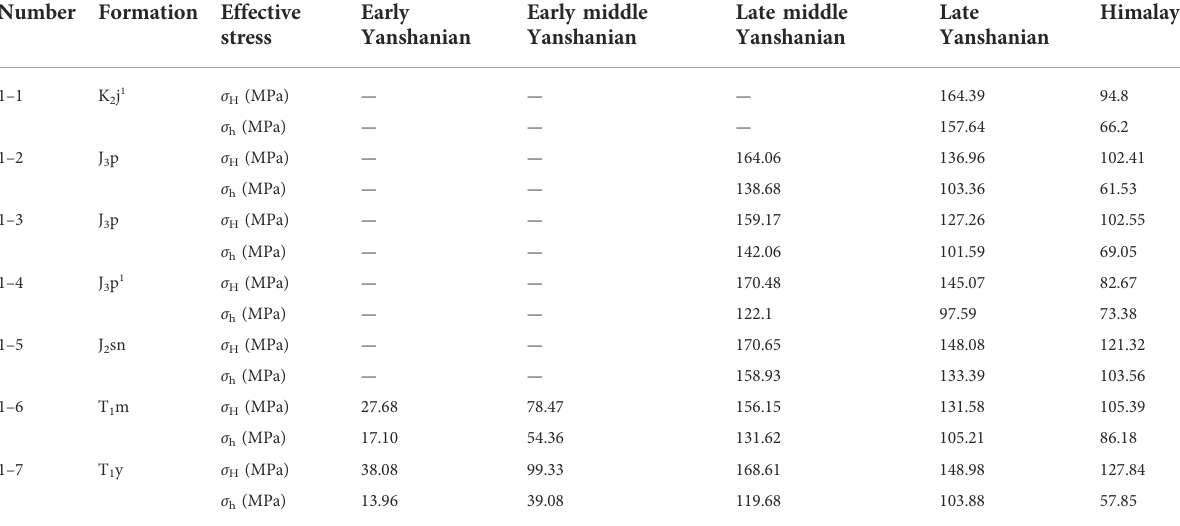
TABLE 2 Test results of rock acoustic emission experiments in Lintanchang area of East Sichuan Basin. Number Formation Effective